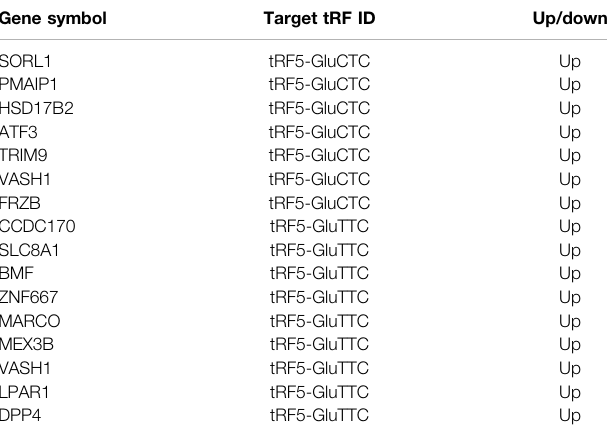
TABLE 3| IntersectingmRNAsbetweendifferentiallyexpressed mRNAsobtained by sequencing and predicted target genes of tRFs. Gene symbol Target tRF